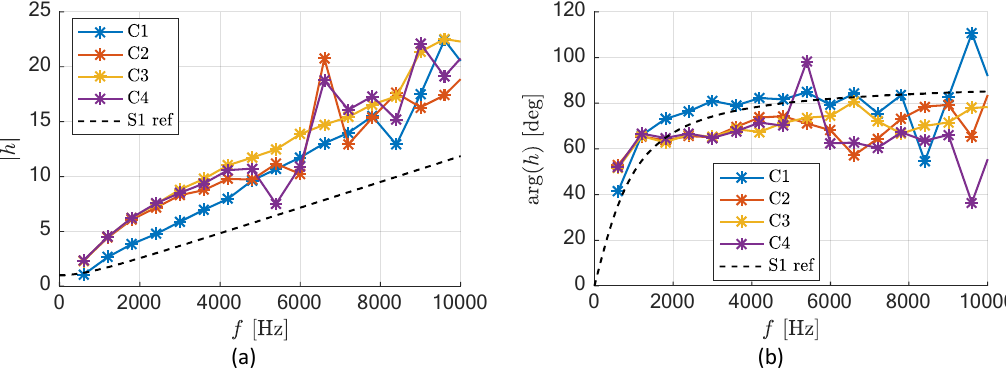
Figure 28: Numerical results of the transfer function for the reference gear pump under four design configurations (from C1 to C4) at 2000 RPM and 200 bar (a) magnitude (b) phase.